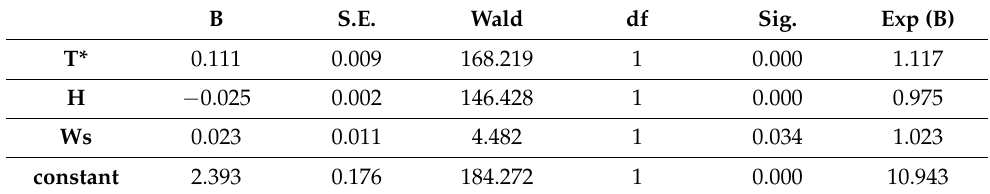
Table 8. Contribution of each variable in the model for predicting snowmelt. Independent variables: average annual temperature ( T* ), average annual minimum temperatures, relative humidity ( H ), and average wind speed ( Ws ) at the weather stations ( MB , MP , PB , S ). Regression indices: independent variable coefficient ( B ), standard error ( S.E. ), test used to determine the significance of each inde- pendent variable ( Wald ), degree of freedom ( df ), statistical significance of the test ( Sig. ), and odds ( Exp (B) ).